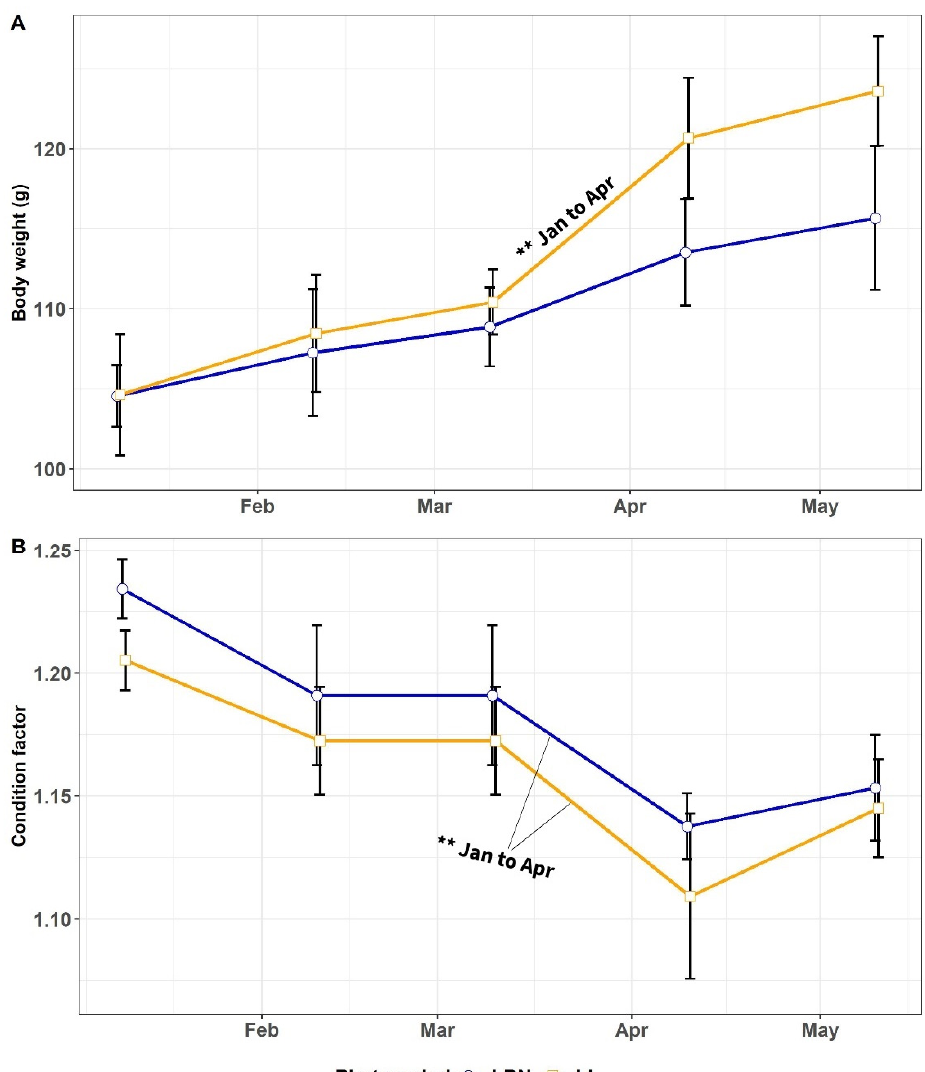
Figure 3. Body weight in g ( A ) and condition factor ( B ) over time in both photoperiod groups during smolti fi cation in FW. Asterisks represent signi fi cant di ff erences in both variables between smoltification in FW. Asterisks represent significant differences in both variables between samplings, samplings, and ** indicates that p < 0.01 (two-way nested ANOVA). Vertical lines indicate SEM. and ** indicates that p < 0.01 (two-way nested ANOVA). Vertical lines indicate